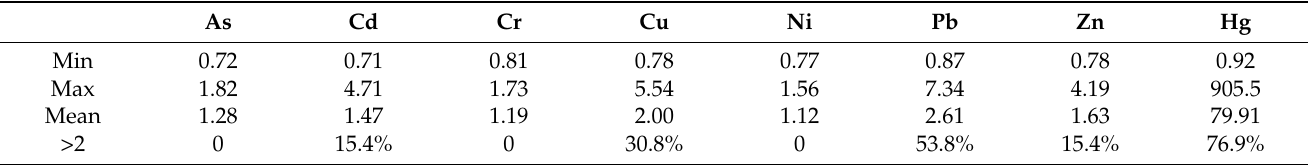
Table A1. TEF values of the HMs in the soil.